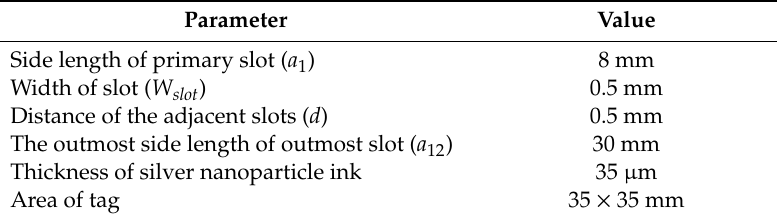
Table 1. Key geometry parameters of 12-bit-tag printed on F4BM substrate.